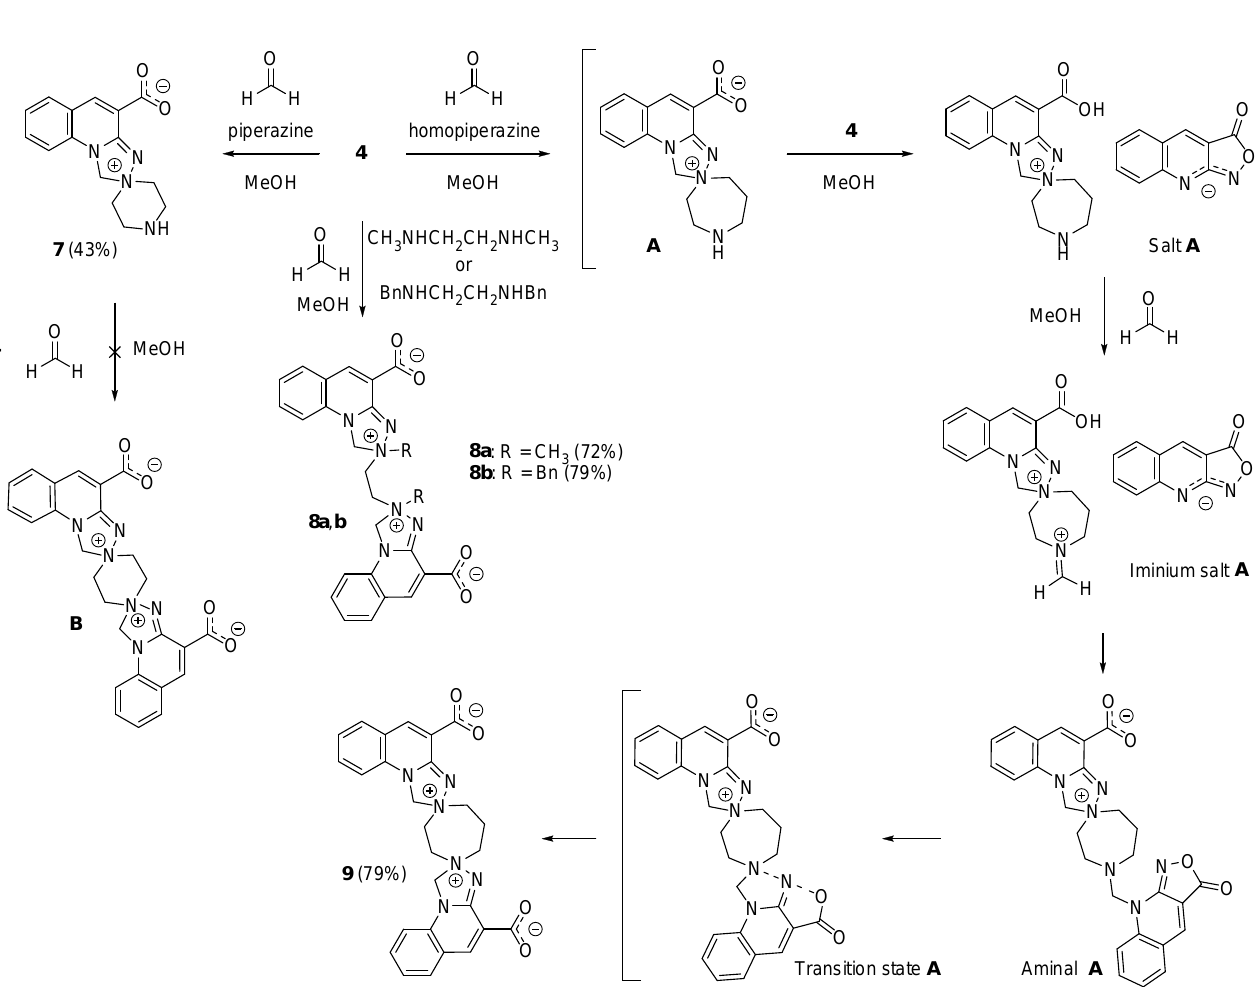
Table 4. The relative electronic (plain text) and Gibbs free (italics) energies (kcal/mol) of subsequent stages of the tandem Mannich — electrophilic amination reactions calculated by DFT/PCM methods.